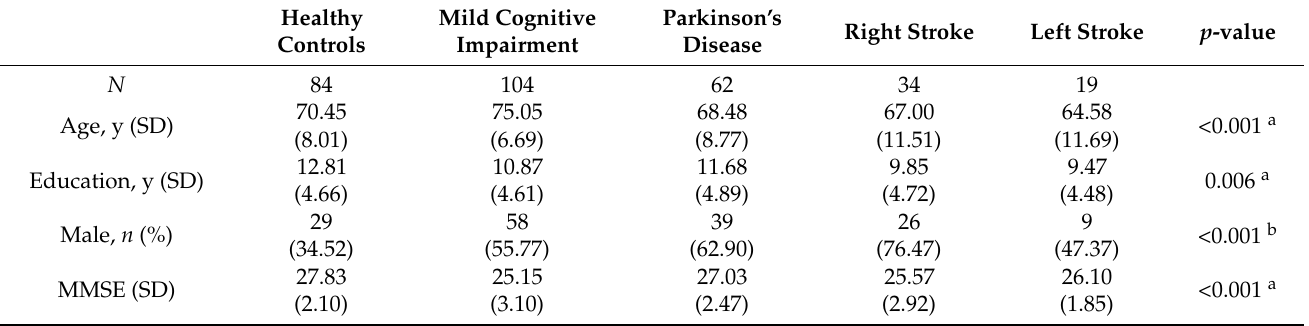
Table 1. Demographic characteristics, means, and standard deviations (SD) or number of participants. Healthy